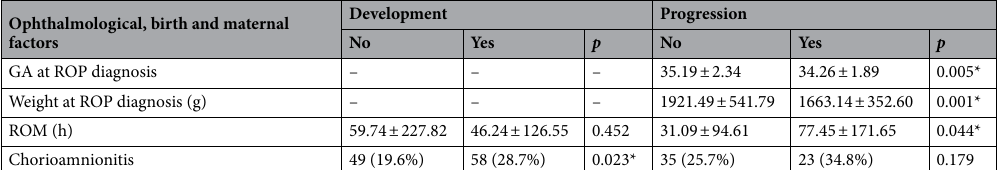
Table 3. Significant ophthalmological, birth and maternal risk factors after univariate analysis for ROP development and progression. GA gestational age (weeks), ROM rupture of membranes (h). *p < 0.005.